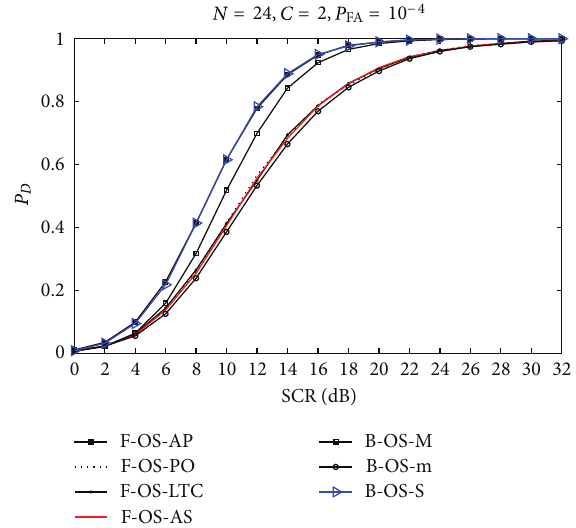
F 4: PD versus SCR performance of distributed detector based on OS CFAR algorithm in local sensors when